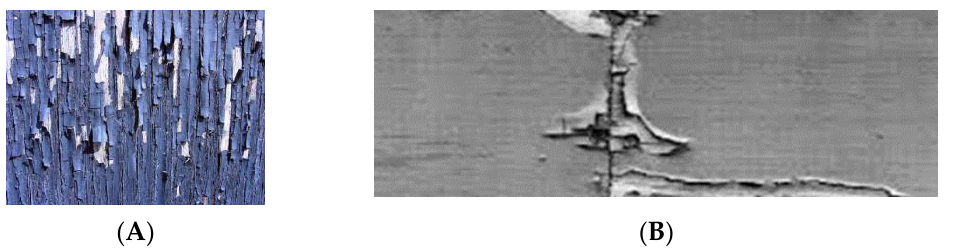
Figure 16. Acrylic paint on the surface of wood.